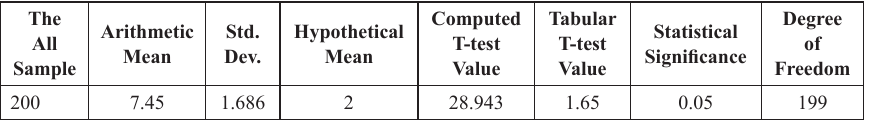
Table 4. The mean and the T-value (questions (correction 1.0))